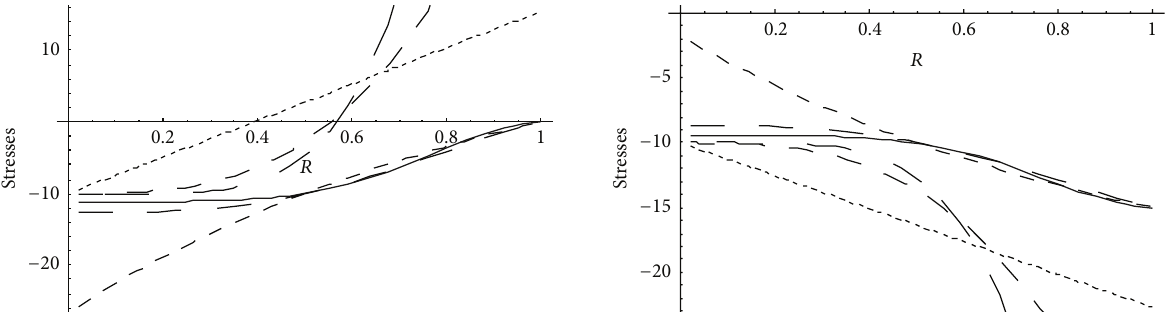
Figure 10: Nonhomogeneous transitional stresses for a thick-walled circular cylinder under internal ( 𝑃 1 = 10 ) and external pressure ( 𝑃 2 = 0 and